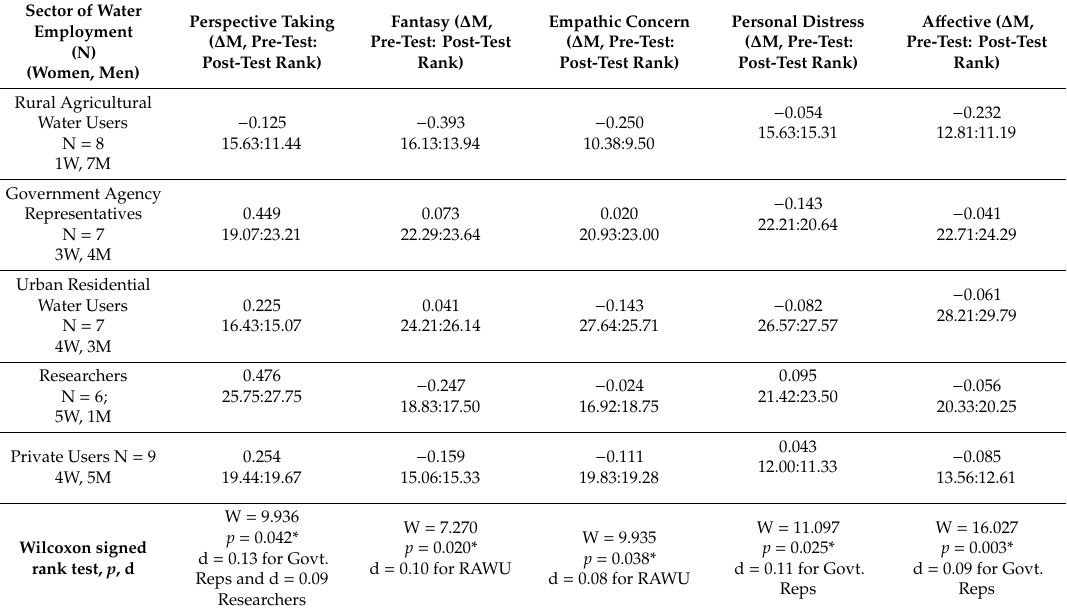
Table 3. Sector-based changes in